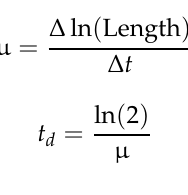
Figure 4. ( a ) Geometry used for the simulation of flow-induced shear stress on the E. coli cell with coordinate system. ( b ) Velocity of the flow through the nanogap in the x-direction over the channel length. ( c ) Cross-sectional view into the channels at the gap area with streamlines around the fixed E. coli model. ( d ) Isometric view into the nanogap area with streamlines flowing around the bacteria. 3.2. Cell Capture Experiments Before growth experiments could be executed, the right pressure settings of the connected pressure controllers had to be evaluated. The conducted experiments consisted of capture and growth phases. For the capture phase, the pressure at the pressure controllers was regulated so that the bacteria sample flowed through the bypass channel 1 from Inlet 1 to Outlet 1. This resulted in a higher pressure at the entrance of the detection channel in the system than in its outlet. The bacteria flowed into the detection channel and were captured at the nanogap by a pressure difference towards the reference channel, schematically shown in Figure 5. Capturing a sufficient number of cells at the nanogap took 3–4 min during typical growth experiments, independent of concentrations varying between 10 6 cells/mL and 10 7 cells/mL. The experimentally obtained pressure settings for the capture are shown in Table 1. Real-time microscopy allowed ideal timing to switch the pressure settings to growth mode. Including the subsequent adjustment of the imaging setup, the preparation time between pre- incubation and the beginning of detection took 15 min on average. The pressure difference between the detection bypass channels was inverted, causing a flow direction from growth medium to bacteria bypass through the detection microchannel. In some cases, pressures were adjusted in more than one step to avoid losing too many cells by flushing. For the duration of 4 h, growth mode was kept constant and the microchip was imaged every 30 s to monitor whether the cells were sufficiently retained and were growing at the nanogap. The pressure values determined to be suitable for the capture and a 4 h retention of the bacteria are summarized in Table 1.